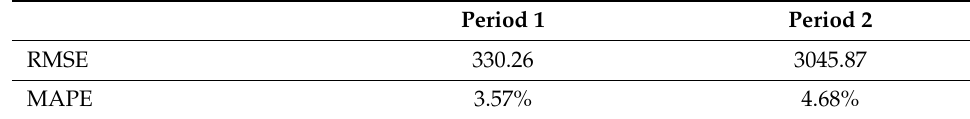
Table 8. Errors of the LSTM models.